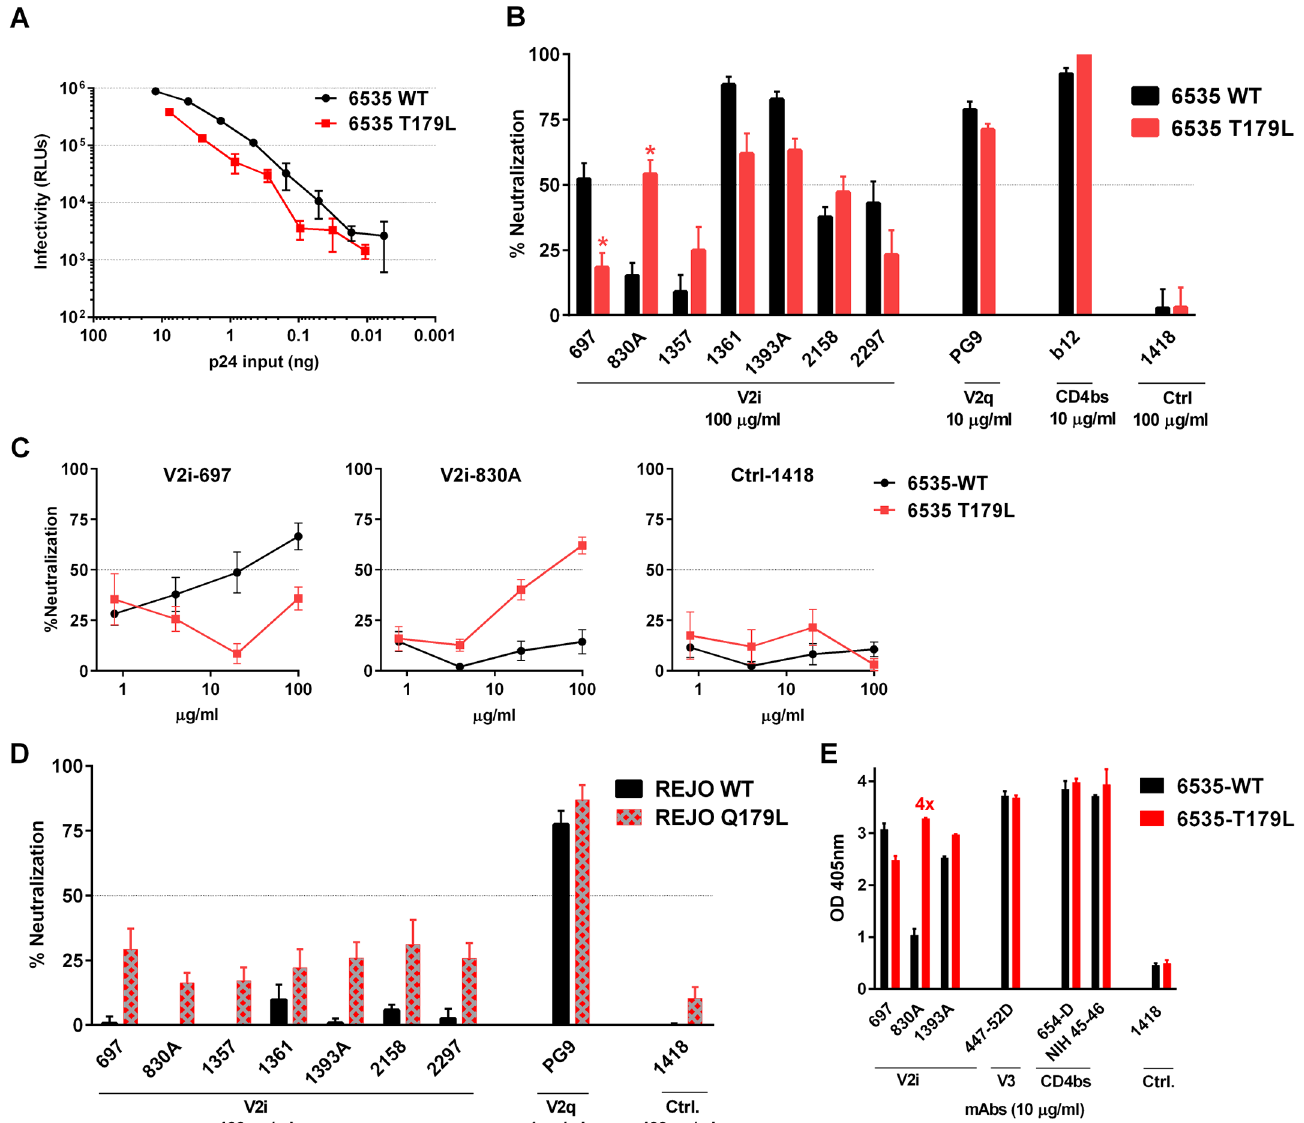
Fig 2. A single mutation creating the LDV motif has minimal effects on neutralization sensitivity of 6535 and REJO pseudoviruses to most V2i mAbs. (A) Infectivity of 6535 and its mutant T179L in the TZM-bl cells. Virus infectivity was measured based on β -galactosidase activity after 48 hrs. (B) Neutralization of 6535 and its mutant pseudoviruses by V2i, V2q, CD4bs, and irrelevant control mAbs. (C) Titration curves showing significant differences in neutralization of 6535 WT vs. T179L mutant by V2i mAbs 697 and 830A. * , p < 0.05 based on two-way ANOVA test of the titration curves. (D) Neutralization of REJO WT and Q179L mutant pseudoviruses by V2i, V2q, and control mAbs. For neutralization assay, virus was pre-incubated with mAb for 1 hr at 37°C, and added to the TZM-bl cells. Inhibition of virus infectivity was measured by β -galactosidase activity. (D) ELISA reactivity of V2i, V3, CD4bs, and control mAbs to gp120 from 6535 WT and T179L mutant. For this assay, gp120s from virus lysates were captured onto 96-well plates by sheep anti-gp120 Abs, and reacted with mAbs tested. MAb binding was detected with alkaline phosphatase-conjugated goat anti-human IgG Fc and p-nitrophenyl phosphate substrate. Means and standard errors from two or more repeat experiments are